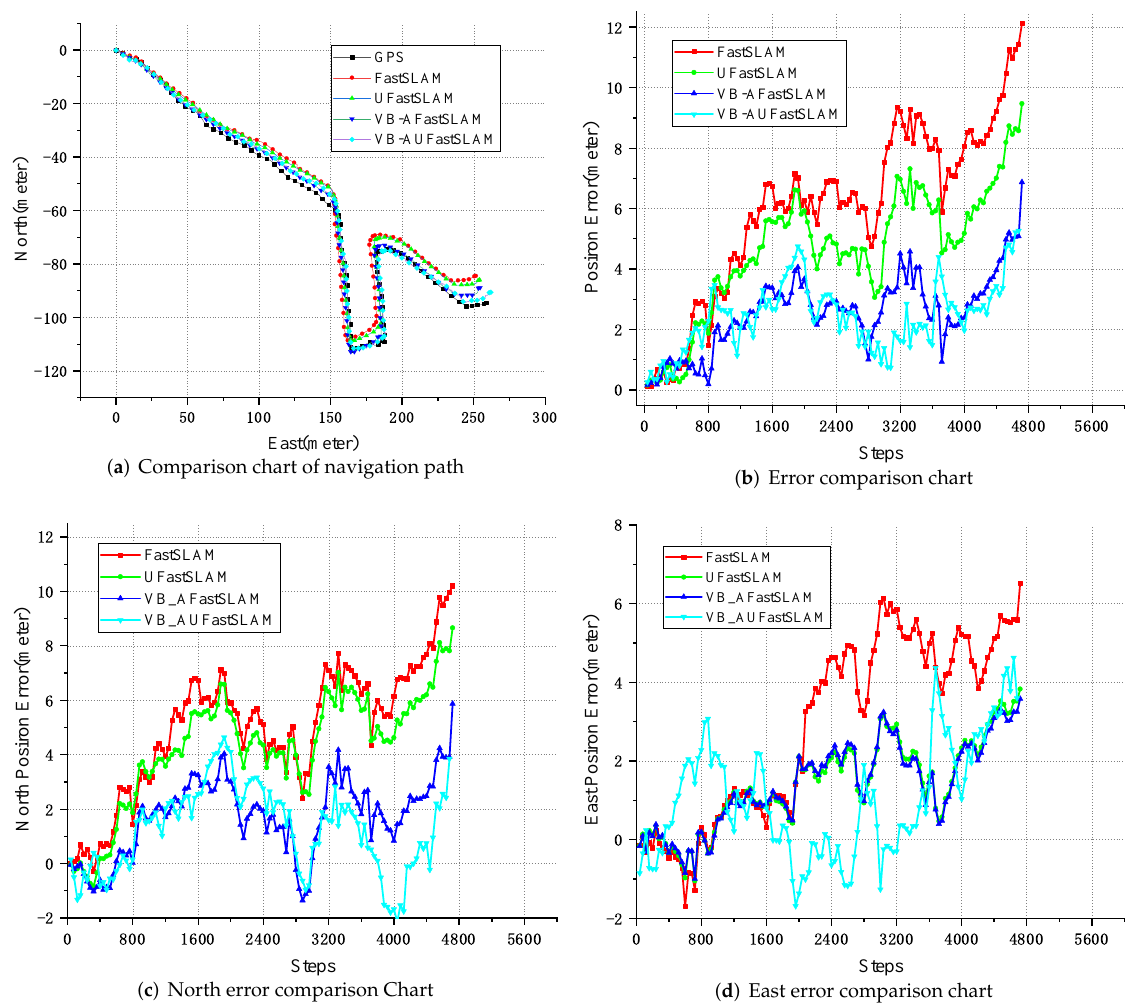
Figure 9. Comparison chart of sea trial trajectory and error comparison of four algorithms.